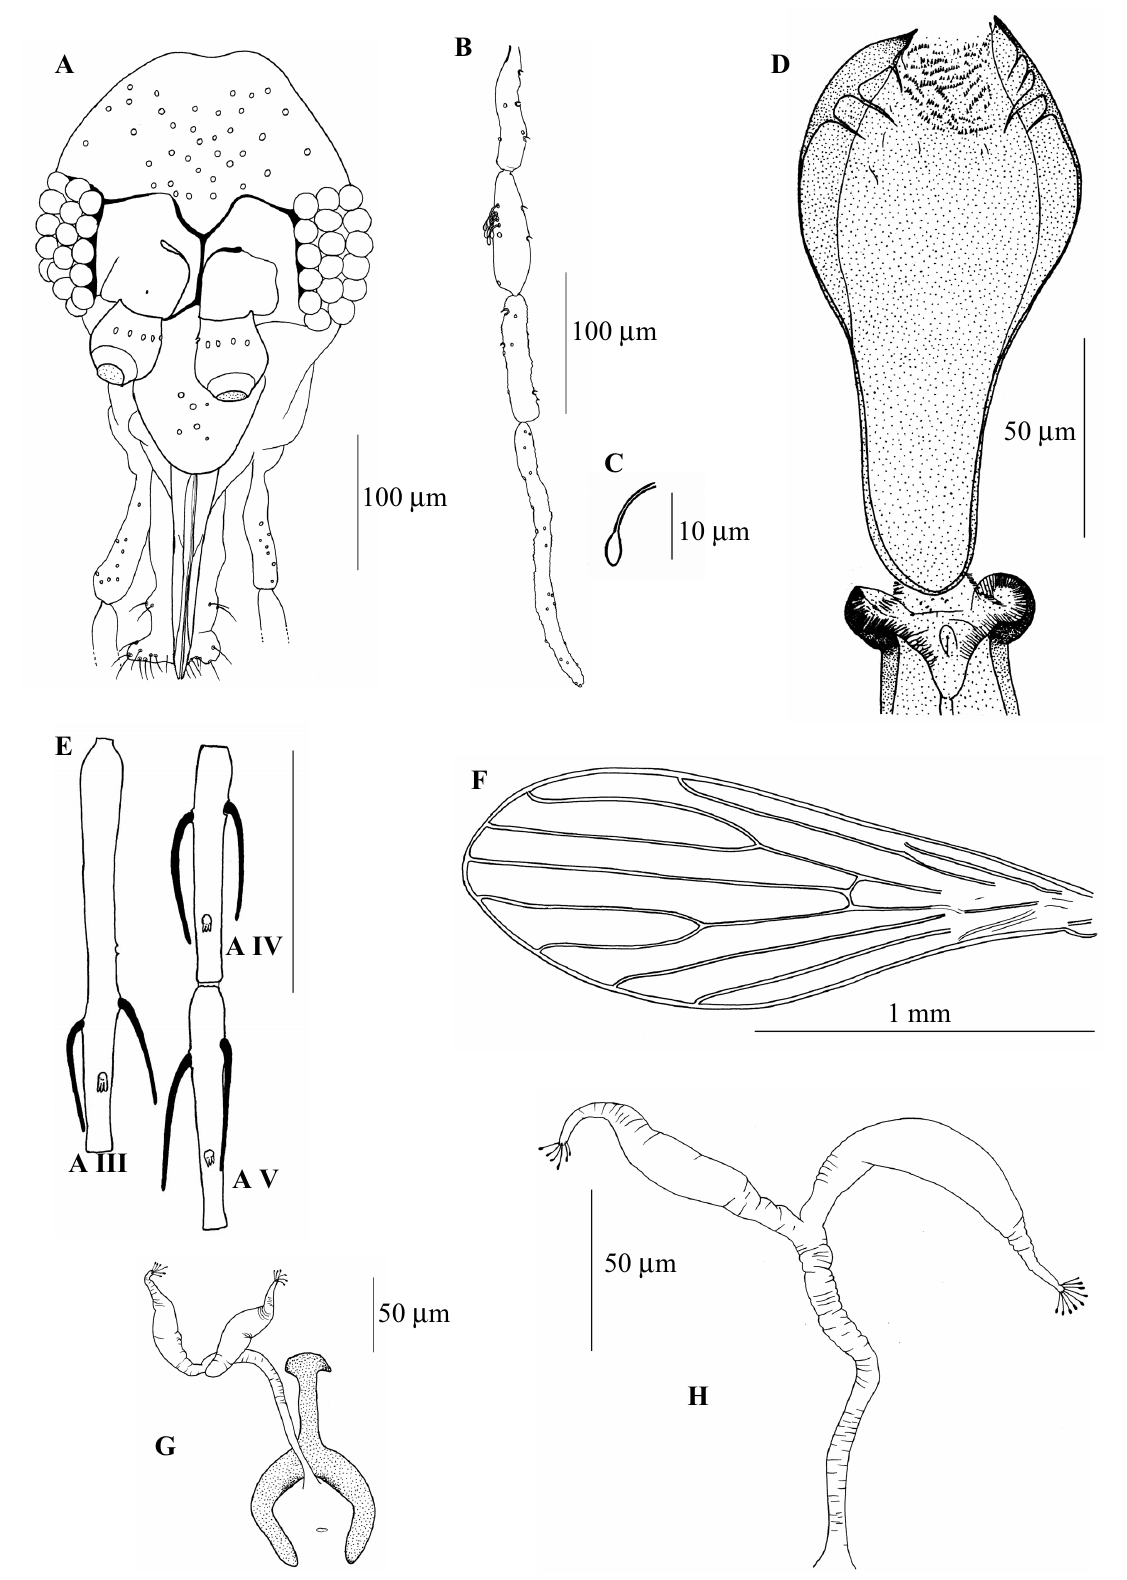
Fig. 1. – C. barbazani n. sp. femelle. A : tête; B : palpe; C : épine de Newstead; D : pharynx et cibarium; E : segments antennaires III, IV et V; F : aile; G : furca et spermathèque (montage provisoire dans le liquide de Marc-André); H : détails de la spermathèque (mon- tage provisoire dans le liquide de